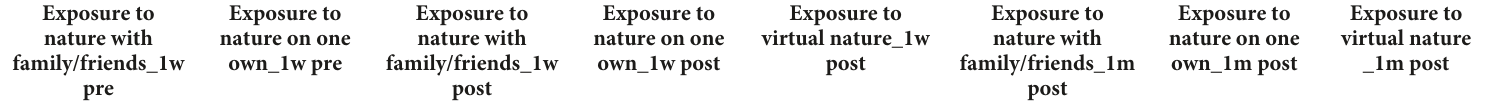
TABLE 4 Correlations of self-constructed items on frequency of exposure to nature or virtual nature for at least 20 min in last week ( N = 90).